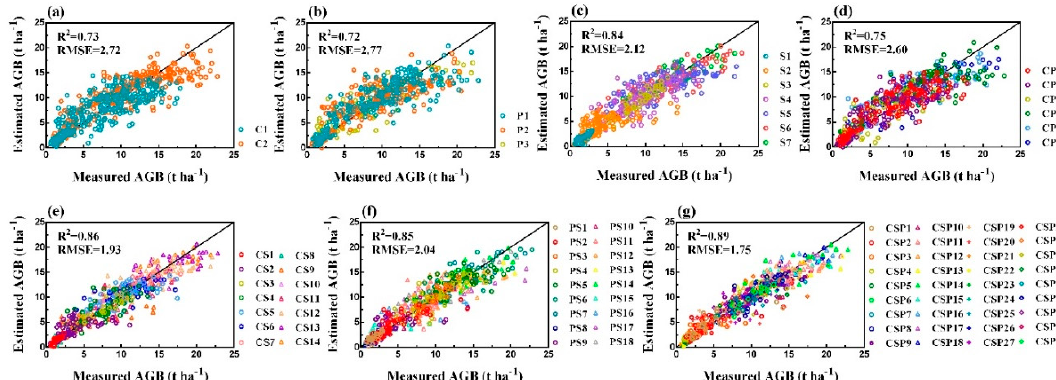
Figure 9. Comparison of LME models (for AGB estimation) with different random effects: ( a ) C, cultivar, ( b ) P, planting pattern, ( c ) S, growth stage, ( d ) CP, combination of cultivar and planting pattern, ( e ) CS, combination of cultivar and growth stage, ( f ) PS, combination of planting pattern and growth stage and ( g ) CSP, combination of cultivar, growth stage and planting pattern. C1-2, P1-3, S1-7, CP1-6, CS1-14, PS1-18 and CSP1-36 represent the groupings of corresponding random effects, respectively.